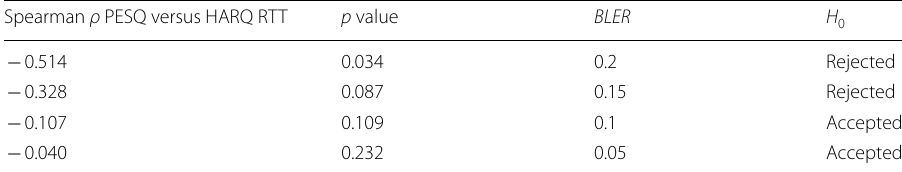
Table 1 Correlation PESQ versus HARQ RTT Spearman ρ PESQ versus HARQ